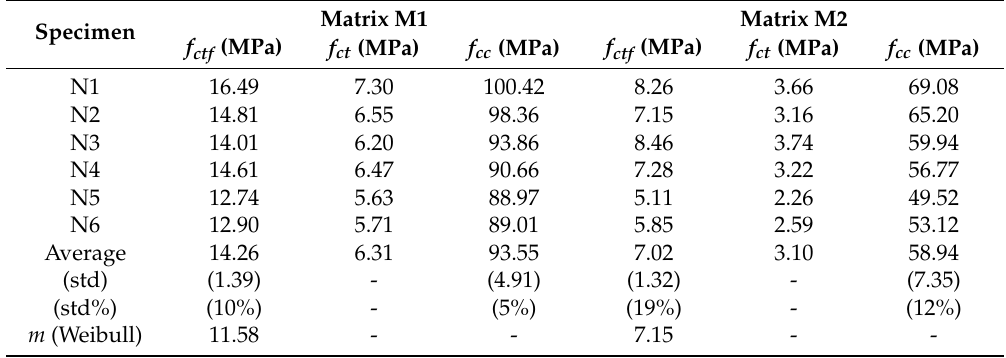
Table 3. Bending, tensile and compressive strengths of matrices M1 and M2: discrete values, average values, standard deviations and shape coefficients m of the two-parameter Weibull distributions.